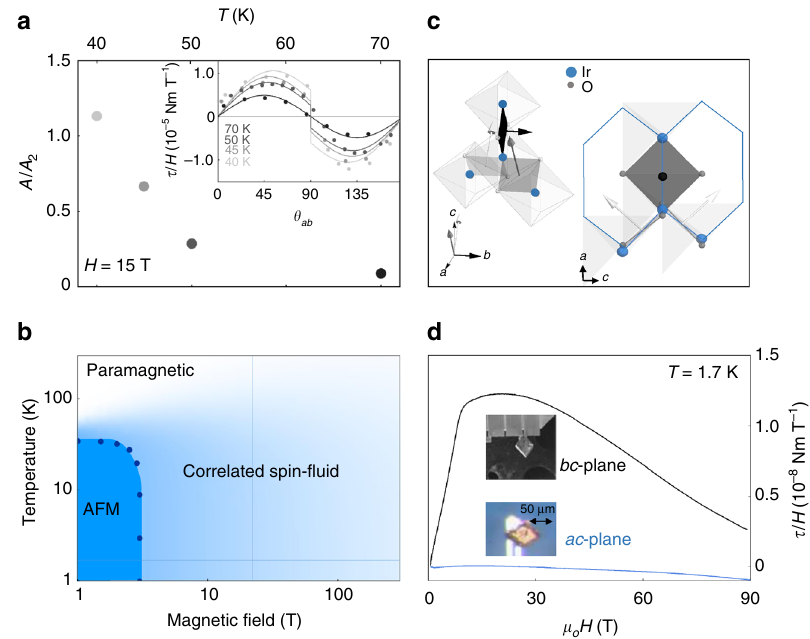
Fig. 4 The temperature/magnetic fi eld phase diagram and its relation to the spin-anisotropic exchange interactions of γ -lithium iridate. a The temperature evolution of the magnetic anisotropy represented by A / A 2 . A and A 2 are the coef fi cients determined by fi tting the fi xed-temperature angle dependence of the torque at fi elds above H * (inset) to τ = H ¼ A sin θ sign ð cos θ Þ þ A 2 sin 2 θ . b Schematic representation of the temperature/magnetic fi eld phase diagram of γ -lithium iridate. At low temperatures, the ordered phase ( dark blue ) extends to H = 3 T for magnetic fi elds along the b-axis. The correlated spin- fl uid ( light blue ) likely persists to magnetic fi elds above 100 T. The faint lines represent regions of the phase diagram explored with constant fi eld and temperature values in a and d , respectively. c The iridium-iridium exchange pathways mediated by oxygen octahedra. The principle components of the exchange tensor J ij between two iridium ions (de fi ned via the exchange energy J ij S i S j ) are determined by the orientation the Ir-O 2 -Ir plaquette which connects them together. The arrows represent the direction perpendicular to the Ir-O 2 -Ir plaquette for each of the nearest neighbor bonds. The view along the b -axis illustrates that only one orientation of the Ir-O 2 -Ir planes is perpendicular to a crystal direction. This is the only direction for which the exchange interaction is fi nite in the Kitaev analysis of the ground state of this complex spin system. d τ / H shown for two principal components of magnetic anisotropy ( α bc and α ac ) up to 90 T, highlighting the special role of M (Supplementary Information of ref. 4 ). The sin 2 θ dependence